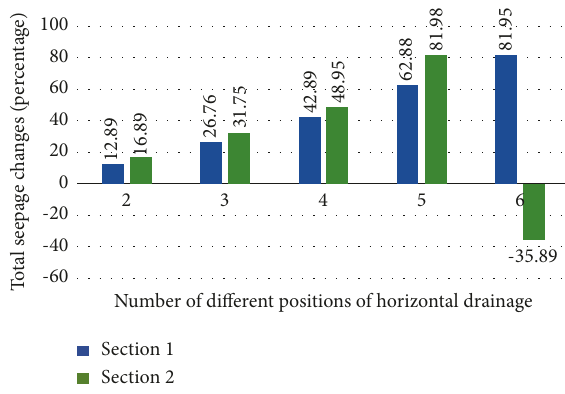
Figure 15: Percentage of changes in total seepage through Sections 1 and 2.